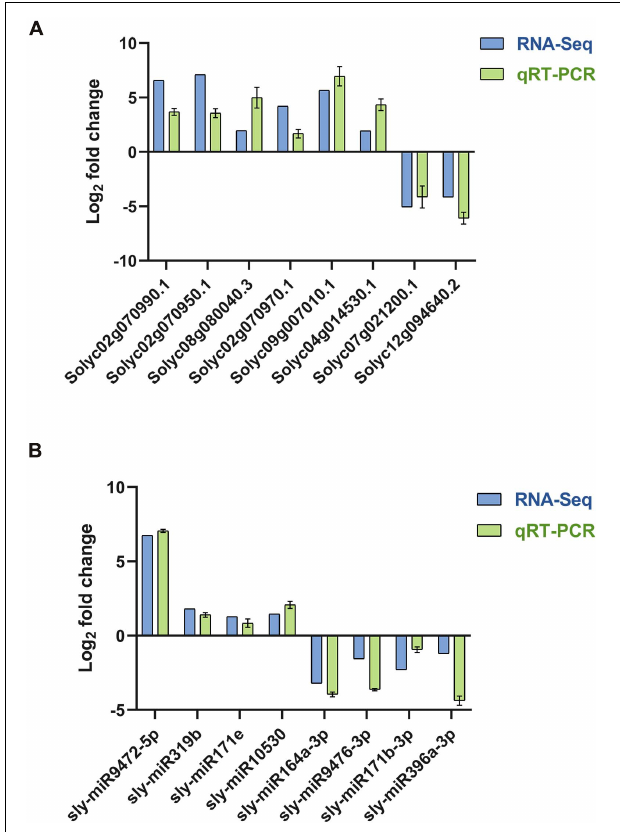
FIGURE 10 | qRT-PCR verified the quality of transcriptome sequencing. (A) The relative expression levels of random mRNAs and the small RNA sequencing results. (B) The relative expression levels of random miRNAs and the small RNA sequencing